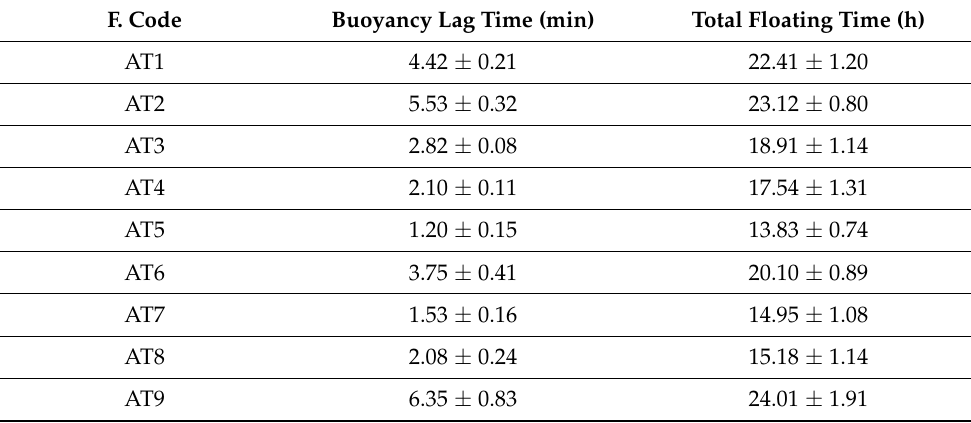
Table 7. Buoyancy study of AT-SR mono tablets.